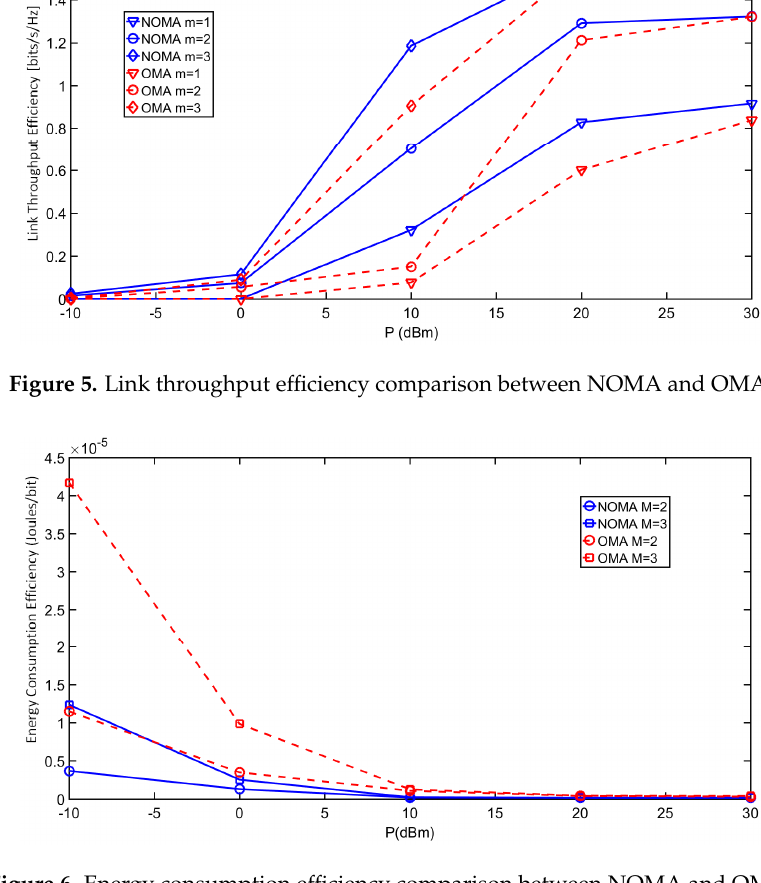
Figure 6. Energy consumption efficiency comparison between NOMA and OMA.